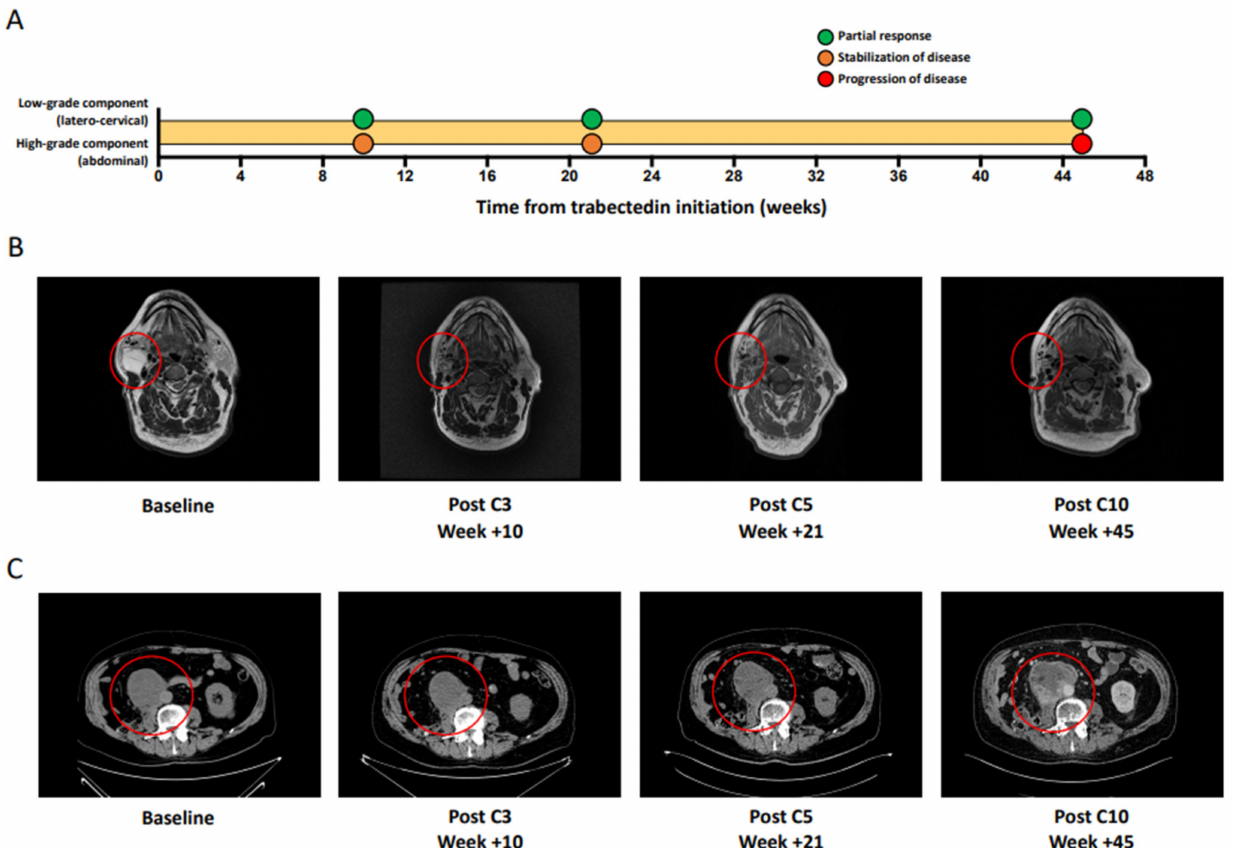
Figure 2. Anecdotal mixed response to trabectedin in a patient with double dedifferentiated liposarcoma (DDLPS) compo- nent. ( A ) shows the different dynamic of response to trabectedin of the low-grade, laterocervical component (low-grade DDLPS) vs. the high-grade, abdominal component (high-grade DDLPS). ( B ) (T2 weighted magnetic resonance imaging) and ( C ) (computerized tomography scan) show the RECIST tumor response at specific time-points of the low-grade, laterocervical component and of the high-grade, abdominal component,